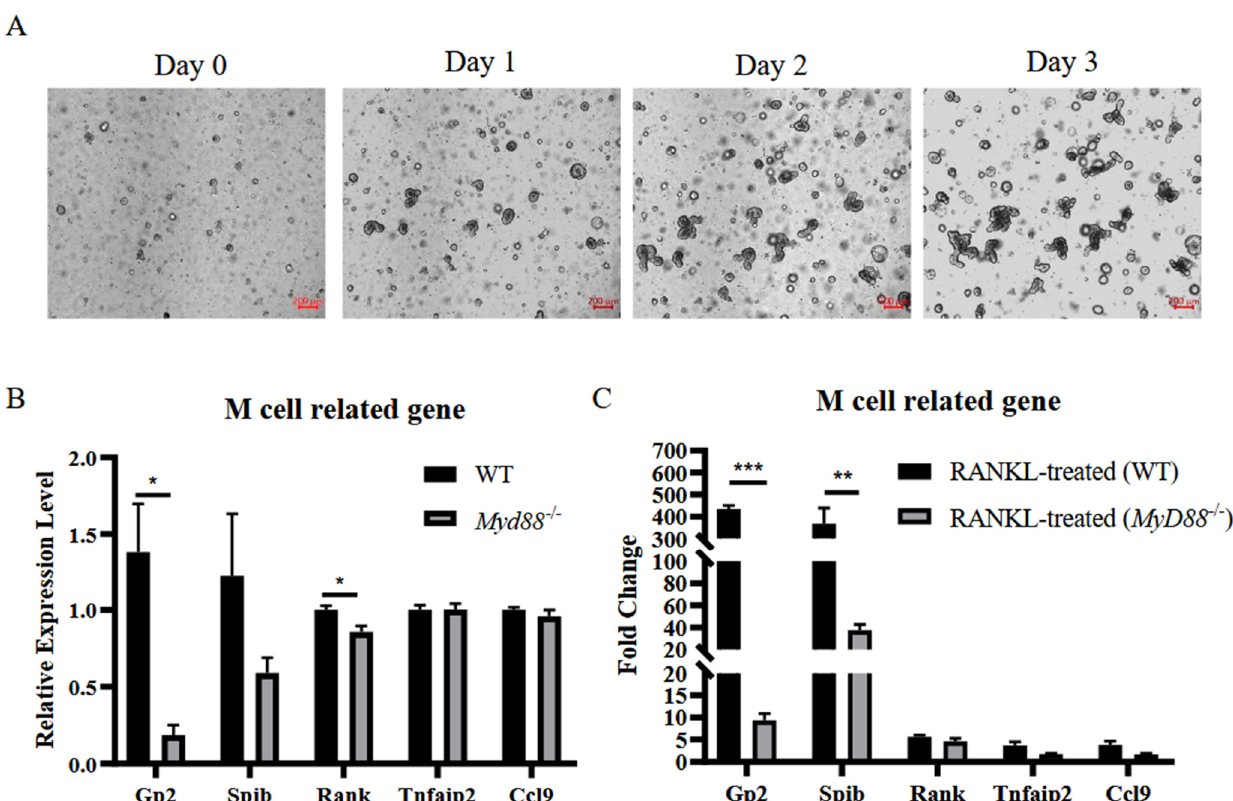
Figure 5. MyD88 is involved in RANKL-induced M cell differentiation. Murine intestinal organoids were established ( A ). Images of WT intestinal organoids were developed under a ZEISS Vert A1 microscope. Scale bar = 200 µ m. Both WT and MyD88 − / − organoids were stimulated with human recombinant RANKL for one day (PBS was used as control) and then were collected for RNA isolation. The mRNA levels of representative M-cell related markers, GP2, Spi-B, RANK, Tnfaip2, and CCL9, in both WT and MyD88 − / − organoids, were detected by RT-qPCR ( B ). The fold change of these markers was compared after RANKL-treatment between WT and MyD88 − / − group ( C ). The data were calculated using the 2 −∆∆ Ct method. In all graphs, data are shown as ‘mean ± SEM’. Results were designated with: * p < 0.05; ** p < 0.01; *** p < 0.001.